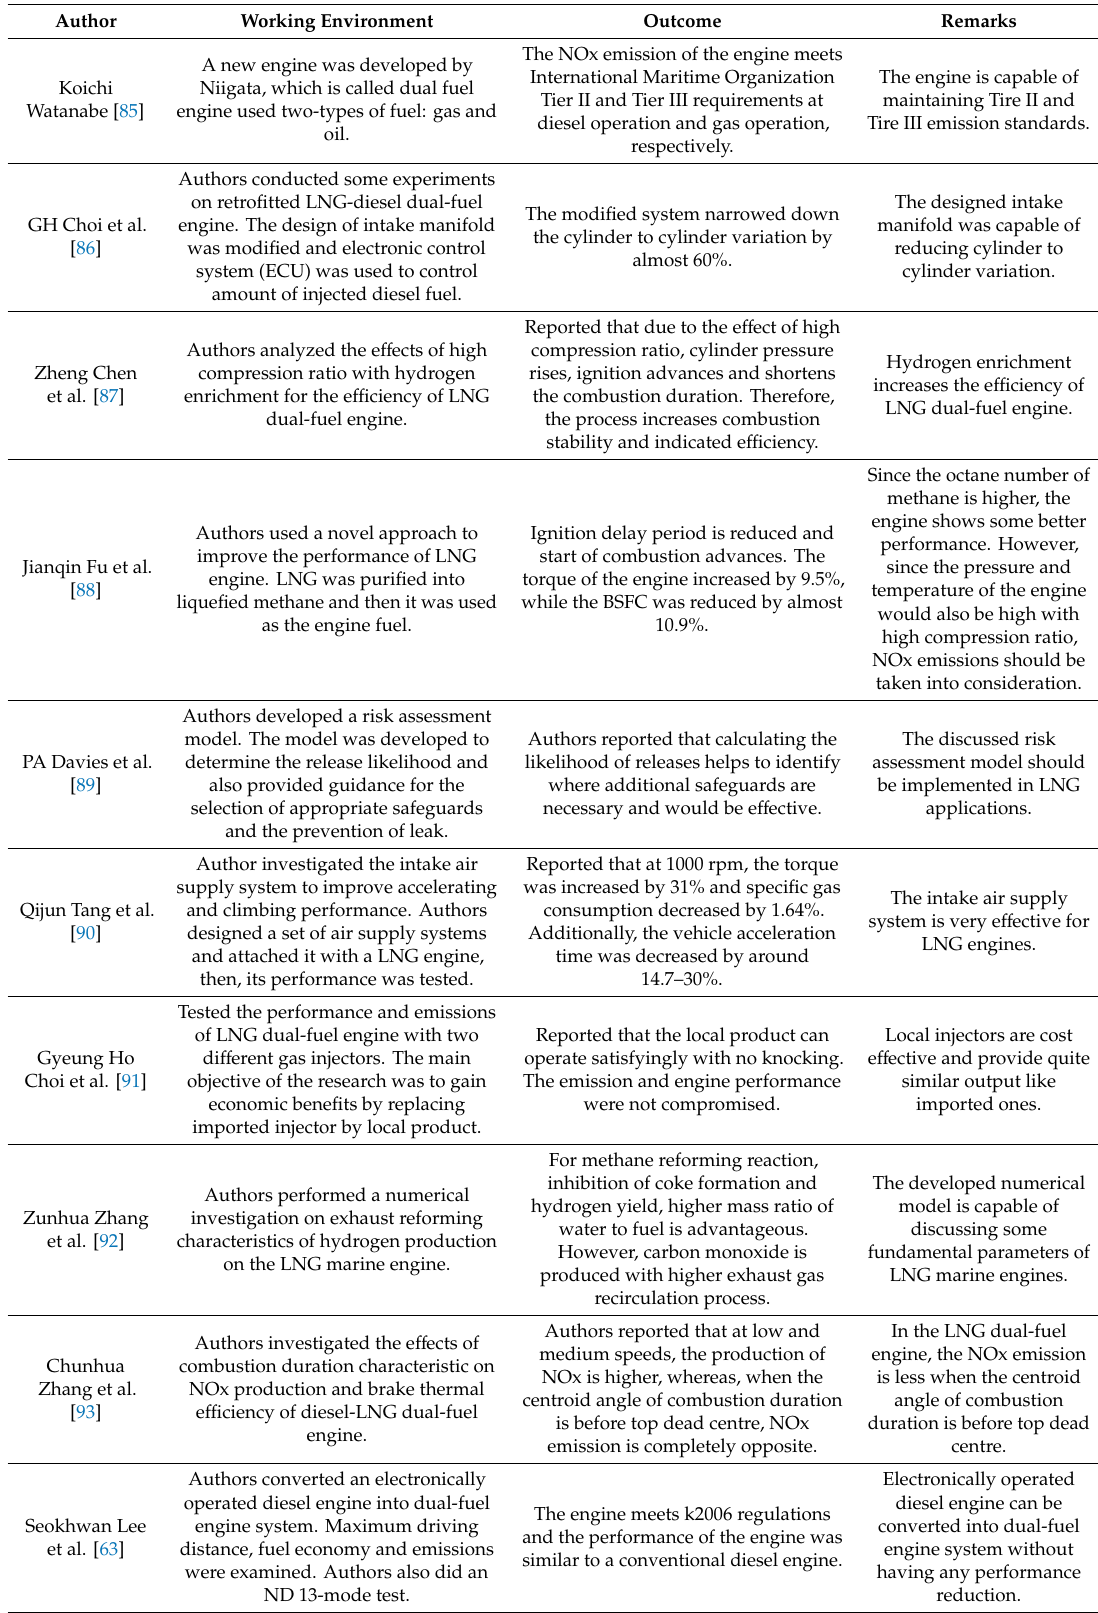
Table 6. Recent advancements on LNG dual-fuel